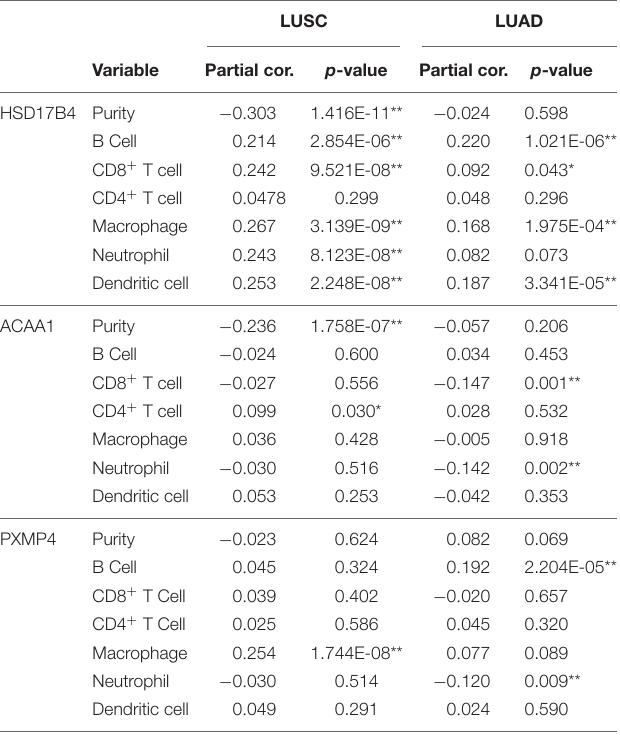
TABLE 2 | The correlations between HSD17B4, ACAA1, and PXMP4 expression and immune infiltrations in NSCLC. LUSC LUAD Variable Partial